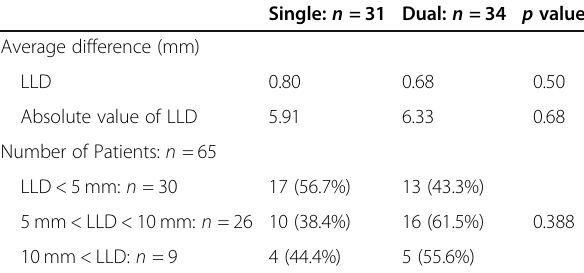
Table 3 Difference of Leg length discrepancy between two